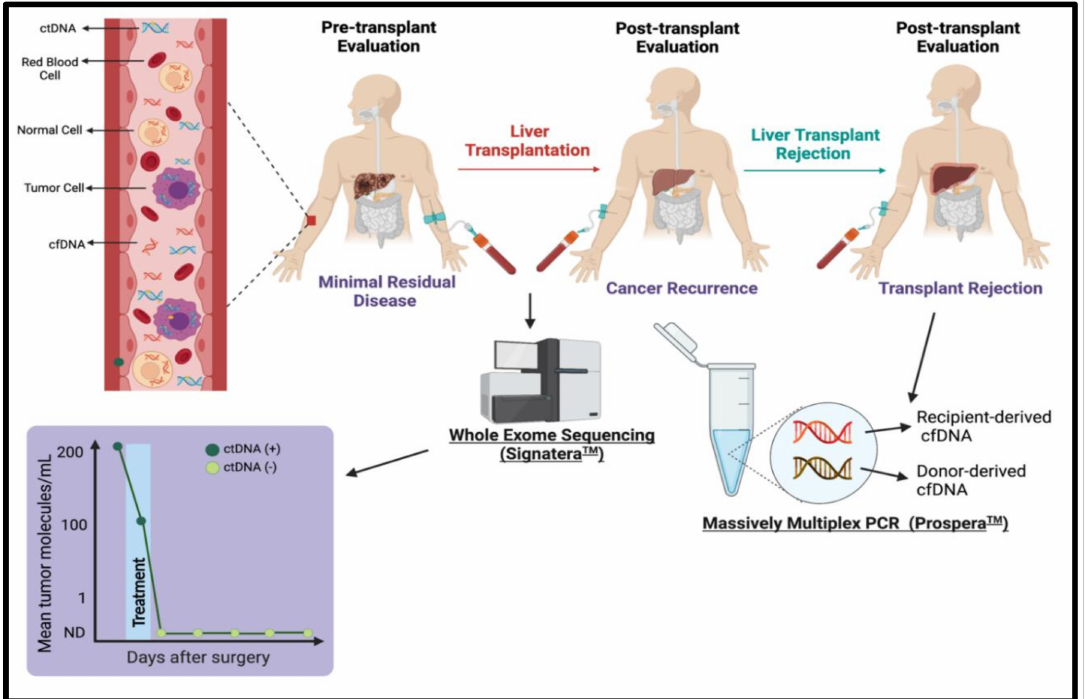
Figure 1. Schematic representation of utilizing cell-free DNA as a biomarker to evaluate minimal residual disease pre-and post-transplant (cancer recurrence), and liver transplant rejection using the Signatera ™ and Prospera ™ Tests, respectively. Figures created with